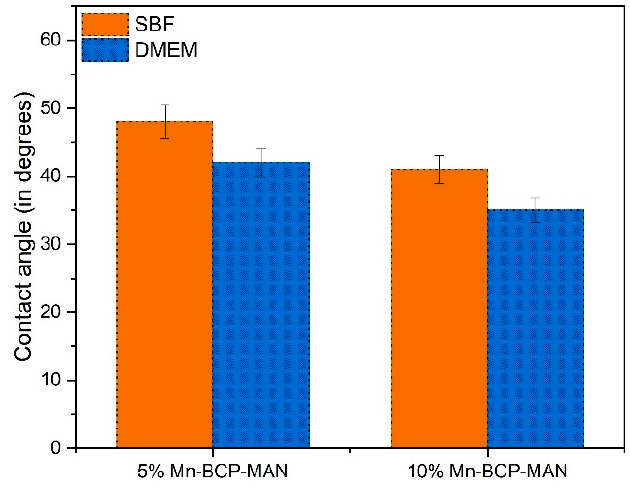
Figure 2. Contact angle of manganese-doped biphasic calcium phosphate scaffolds.